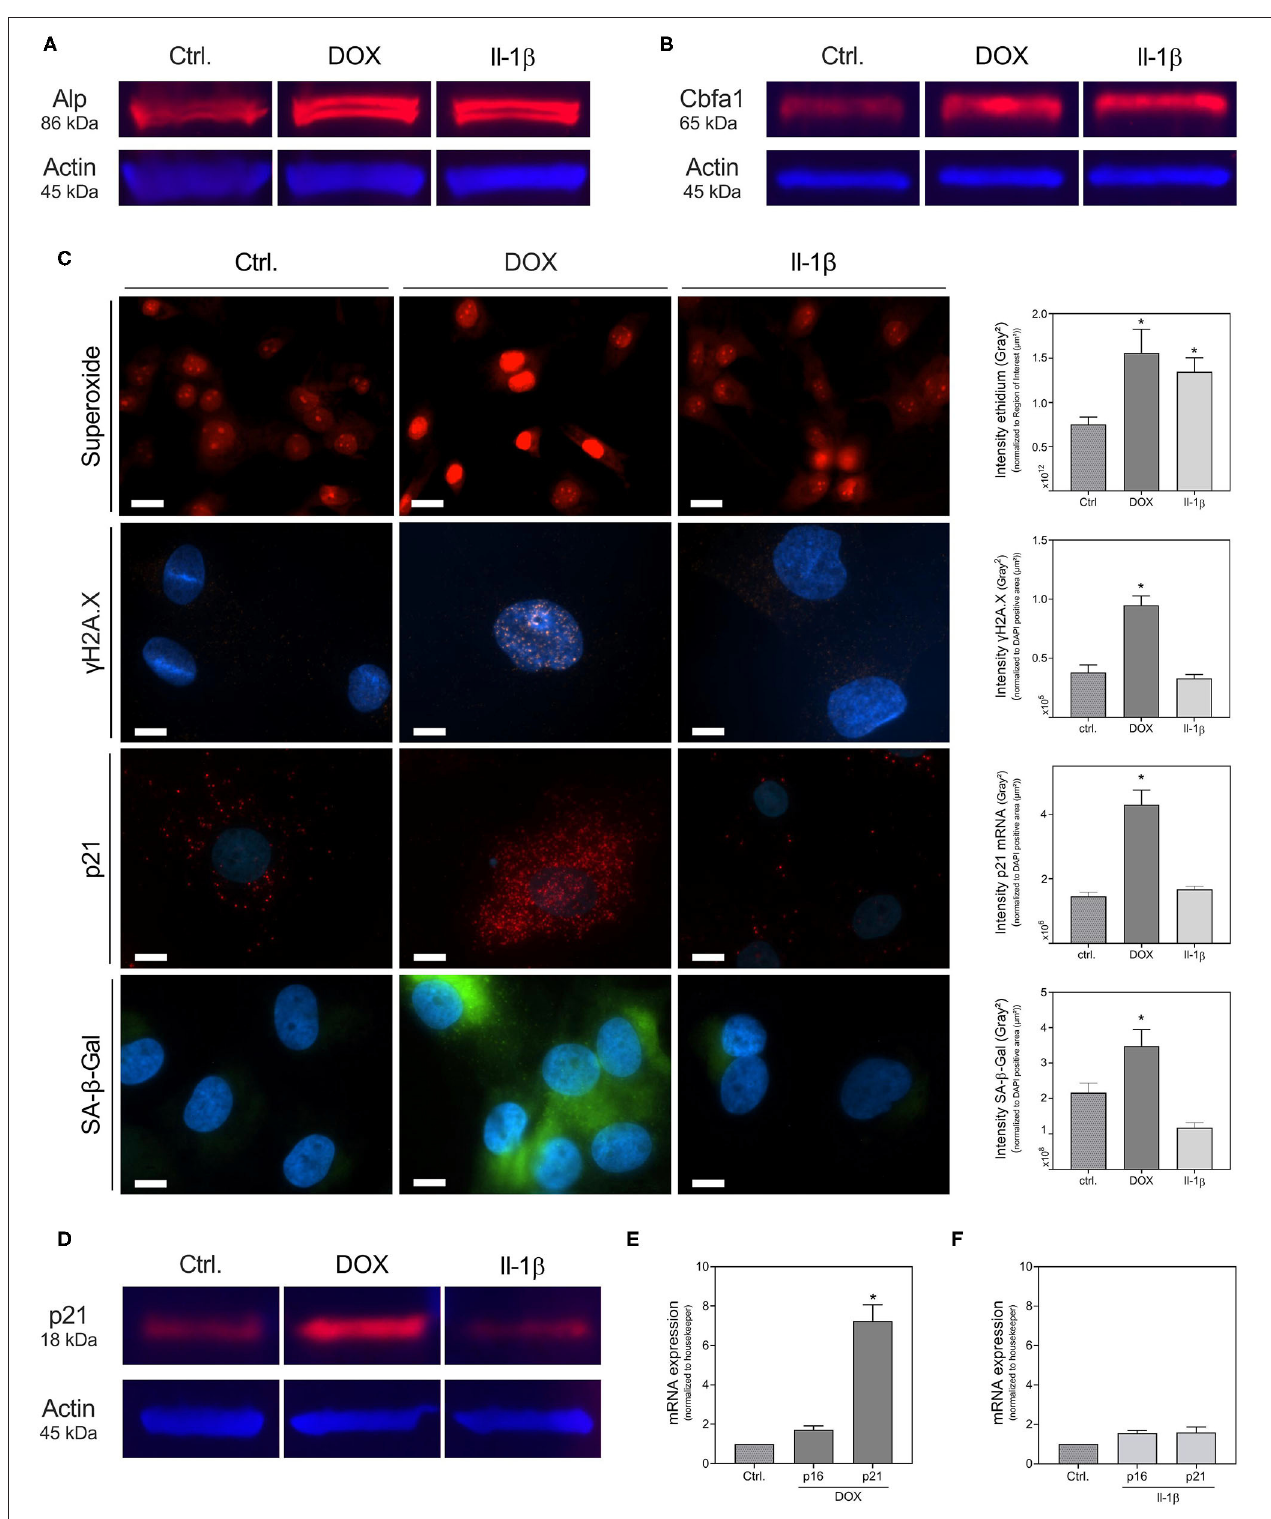
FIGURE 5 | Formation of calcification markers, reactive oxygen species and senescence upon DOX and Il-1 β treatment. VSMCs were stimulated for 30min (superoxide), 48h [ (A,B) , γ H2A.X, p21 in situ (D–F) ], or 72h (SA- β -Gal) with 100ng/ml Il-1 β or 1000 nmol/l DOX in quiescence medium (C,E,F) or culture